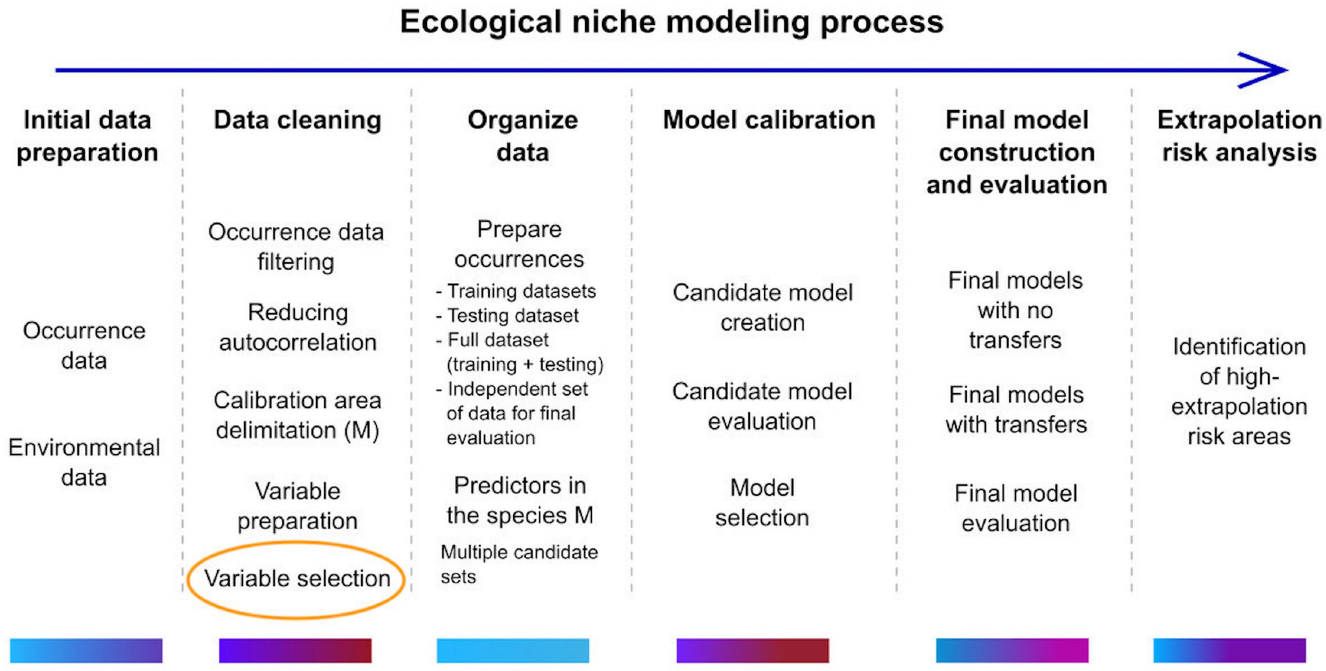
Fig 4. Ecological niche modeling process. Schematic description of the ecological niche modeling process. Color bars under each step reflect an approximate range of times that may be needed, ranging from low (blue) to high (red). Use of a Monte Carlo method to prescreen a large collection of predictors could support variable selection in the data cleaning step. Image provided by [22] and adapted for use here under a CC-BY license.